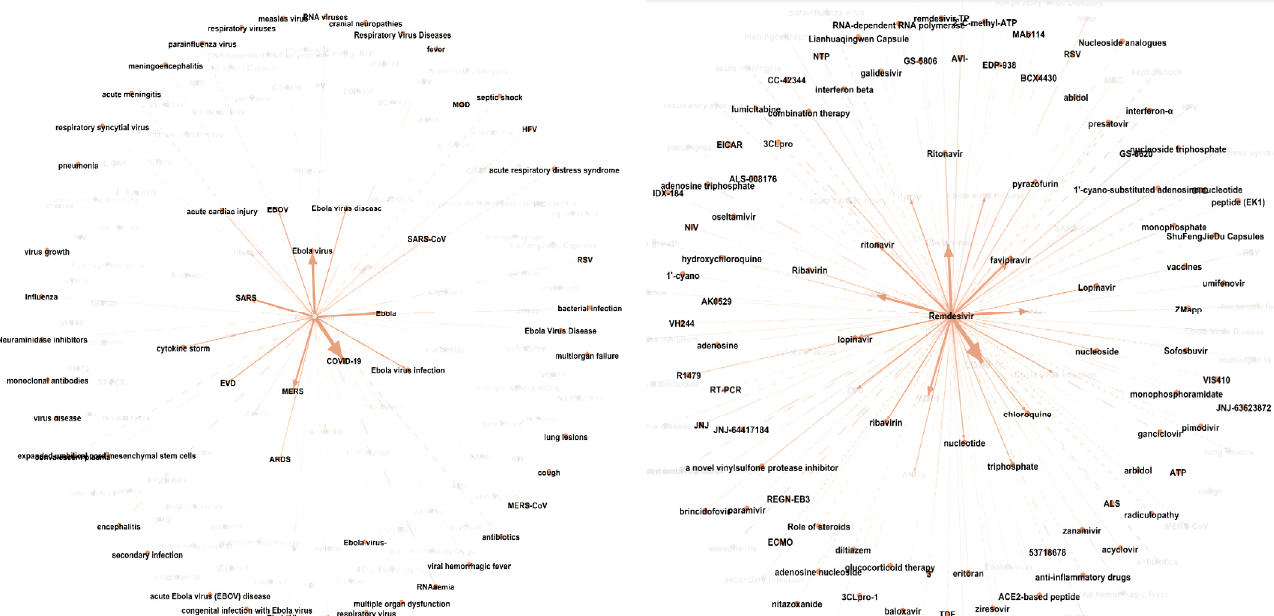
Figure 7. Remdesivir-related KGs: associated diseases (left) and associated drugs (right) based on co-occurrence frequency. Reproduced with permission from Chen et al. [30].